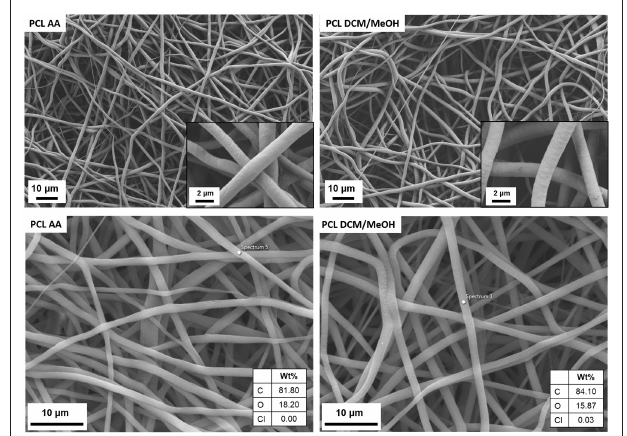
FIGURE 1 | SEM micrographs at different magnifications of PCL electrospun fibers obtained by using acetic acid (PCL AA) and dichloromethane/methanol (PCL DCM/MeOH) as solvents. EDX analysis is reported at the bottom for both samples.